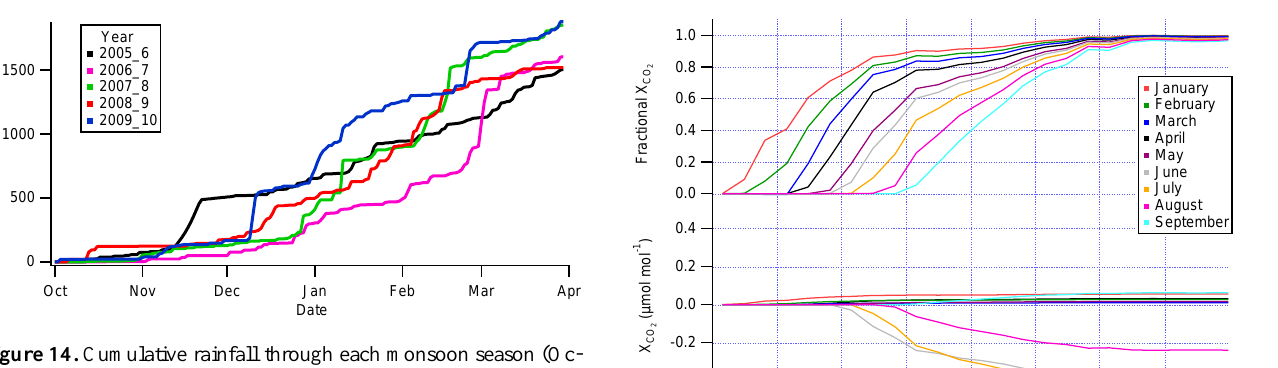
change at Darwin due 2 due to 2